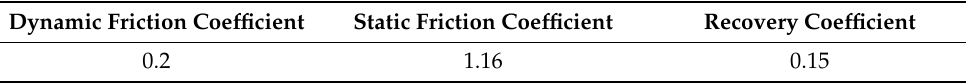
Table 7. Contact parameters of soil particles.